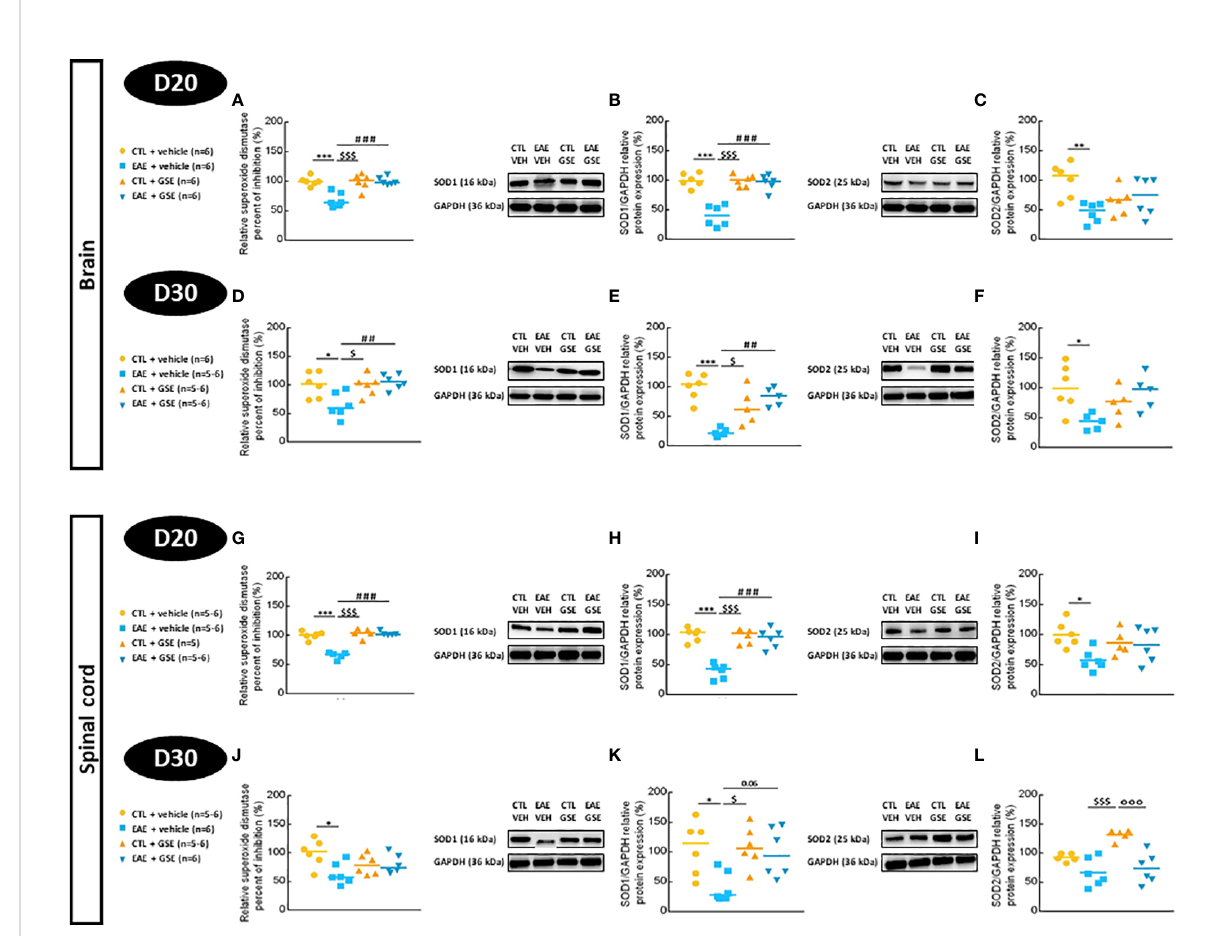
FIGURE 4 Evaluation of superoxide dismutase activity and protein expressions in the brain and spinal cord of experimental autoimmune encephalomyelitis mice (EAE) and their controls (CTL) after curative treatment with grape seed extract (GSE) or vehicle. Superoxide dismutase activity was expressed as the relative percent of inhibition (%) compared to CTL + vehicle group, in the brain (A, D) and the spinal cord (G, J) at D20 (A, G) or D30 (D, J) post-induction. SOD1/GAPDH protein expression was expressed as the relative protein expression (%) compared to CTL + vehicle group, in the brain (B, E) and the spinal cord (H, K) at D20 (B, H) or D30 (E, K) post-induction. SOD2/GAPDH protein expression was expressed as the relative protein expression (%) compared to CTL + vehicle group, in the brain (C, F) and the spinal cord (I, L) at D20 (C, I) or D30 (F, L) post-induction. For each protein level quanti fi cation, a representative Western blotting image of the target protein and loading control is proposed. Statistical analysis was performed using one-way ANOVA followed by Tukey ’ s multiple comparison test: *p < 0.05, **p < 0.01, ***p < 0.001 EAE + vehicle vs CTL + vehicle; ##p < 0.01, ###p < 0.001 EAE + GSE vs EAE + vehicle, $p < 0.05, $$$p < 0.001 EAE + vehicle vs CTL + GSE and °°°p < 0.001 EAE + GSE vs CTL +